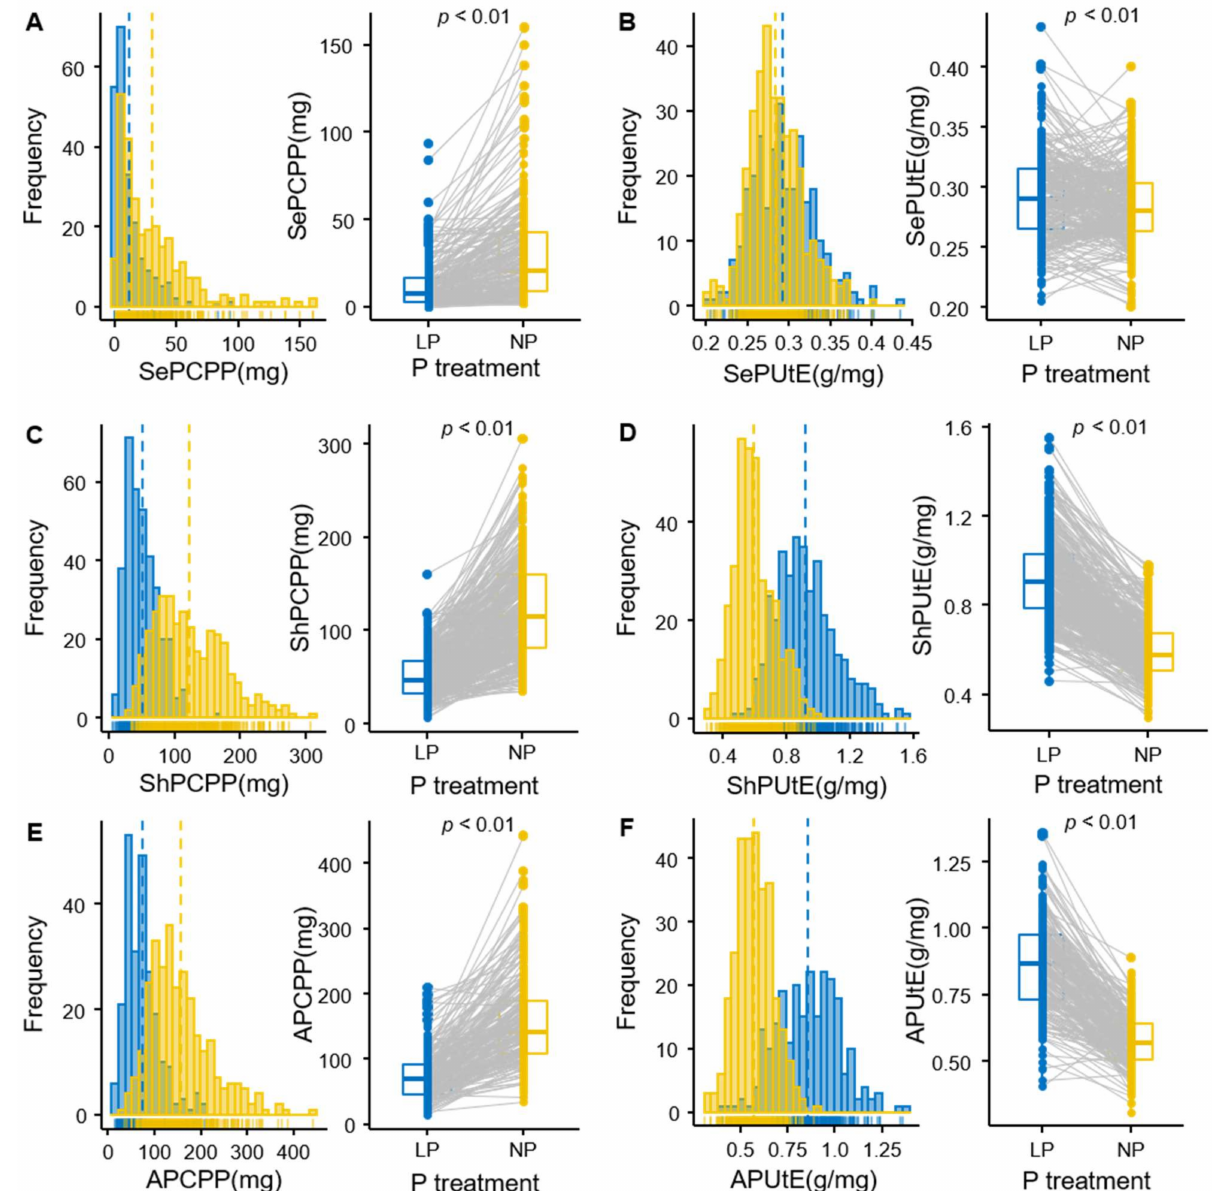
Figure 1. Distribution and interaction of traits under low-P and normal-P treatments. ( A ) SePCPP. ( B ) SePUtE. ( C ) ShPCPP. ( D ) ShPUtE. ( E ) APCPP. ( F ) APUtE. SePCPP: Seed P content per plant; SePUtE: Seed P utilization efficiency; ShPCPP: Shoot P content per plant; ShPUtE: Shoot P utilization efficiency; APCPP: P content per plant; APUtE: All P utilization efficiency. The significant difference was calculated by t -tests between the phenotypes under low-P and normal-P conditions for all